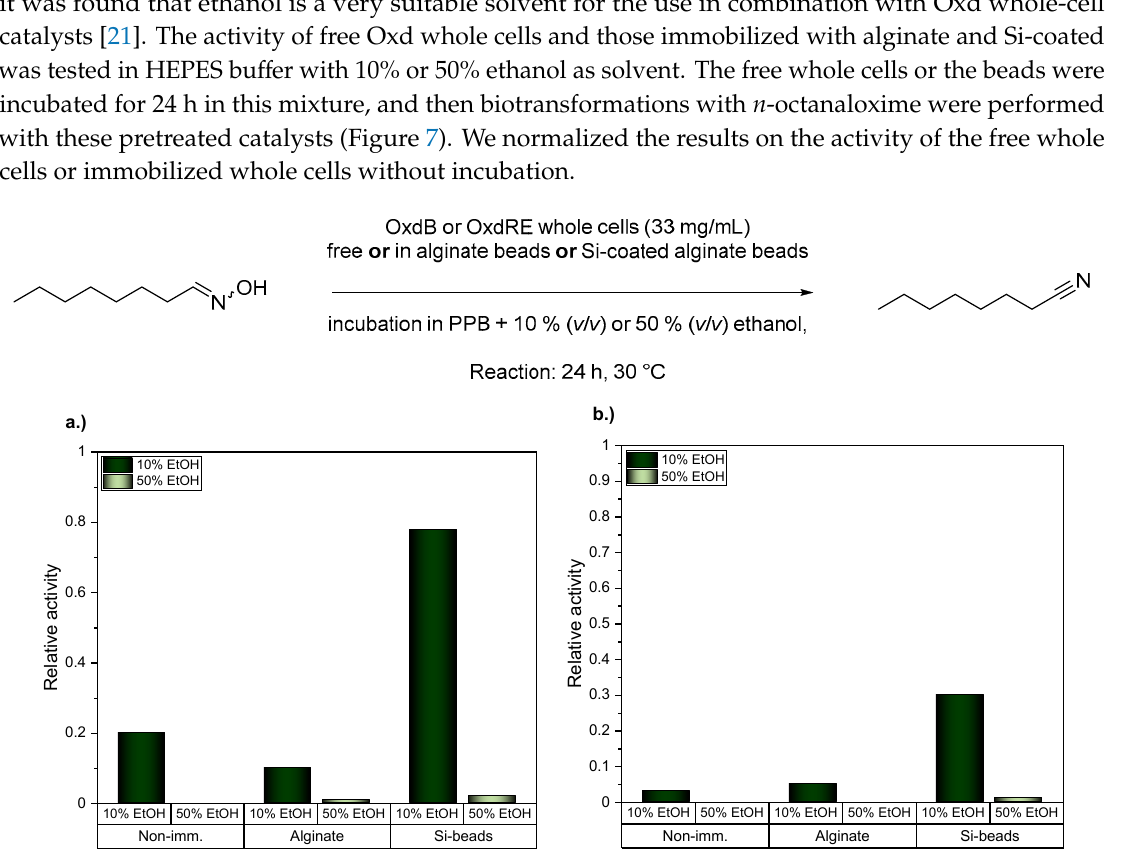
Figure 7. Incubation of ( a ) OxdB and ( b ) OxdRE whole cells (free, non-immobilized), immobilized in calcium alginate (alginate) or in Si-coated calcium alginate (Si-beads)) in 10% or 50% ethanol in HEPES. The relative activity in comparison with standard activity of dehydration is shown.